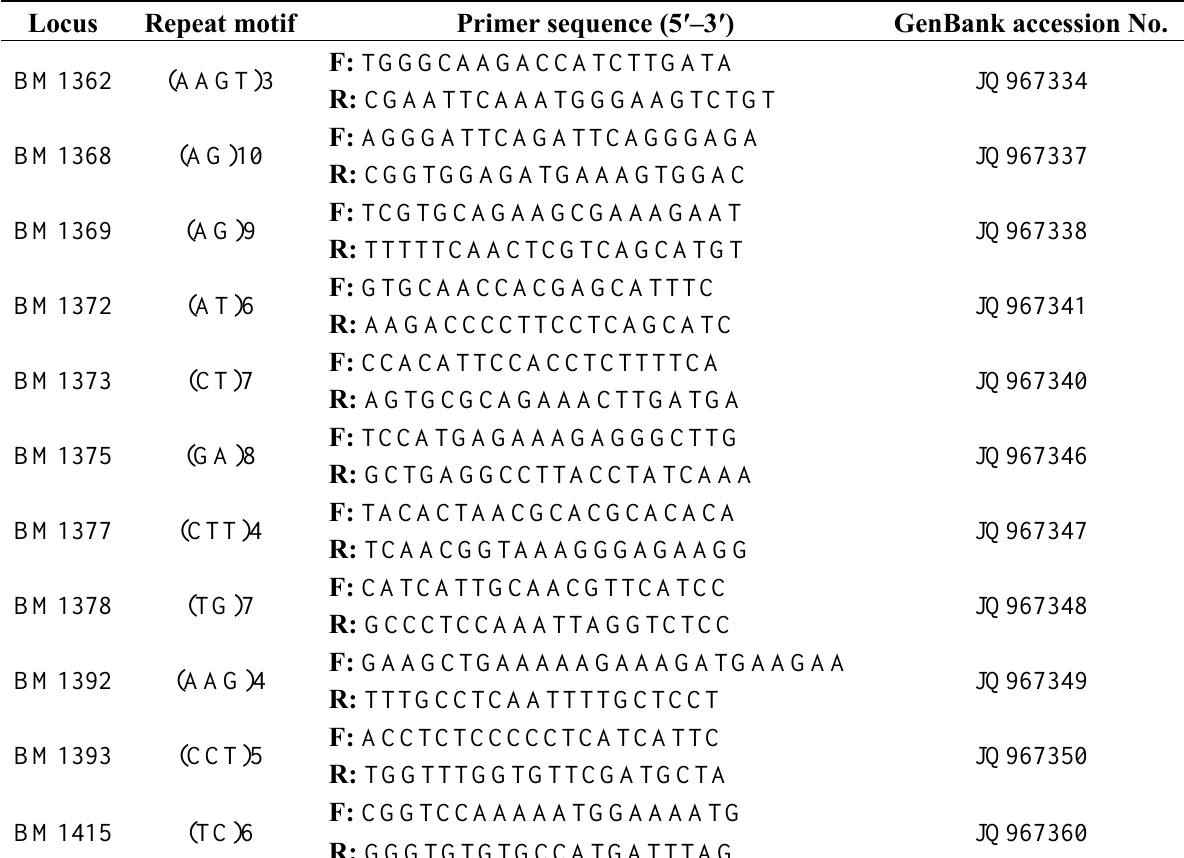
Table 1. Characteristics of 30 new microsatellite markers developed in Nilaparvata lugens.